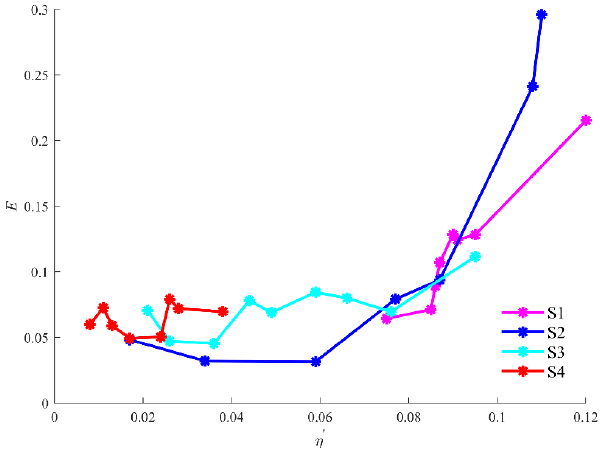
Figure 5. Variation in E with ' in different stratifications.